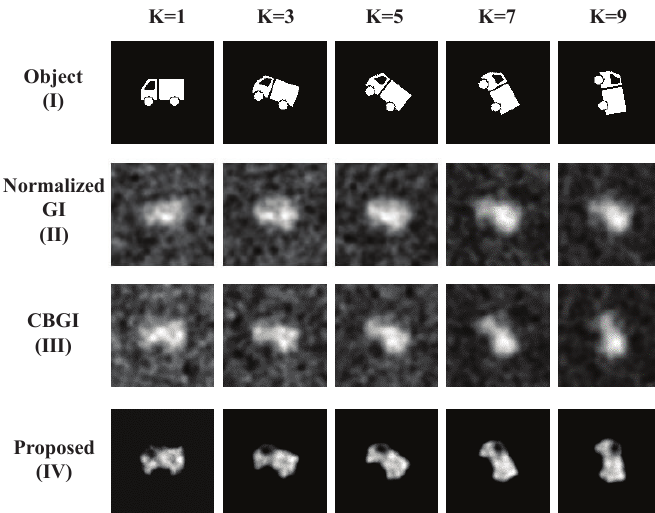
Figure 4. Reconstructed images of ( I ) the ideal rotating object, ( II ) normalized GI, ( III ) CBGI, ( IV ) CS with the rotation angle estimation, with the same image period m =